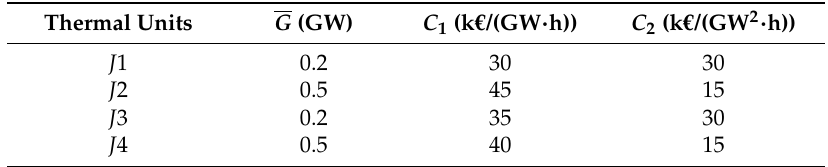
Table 1. Parameter data of thermal